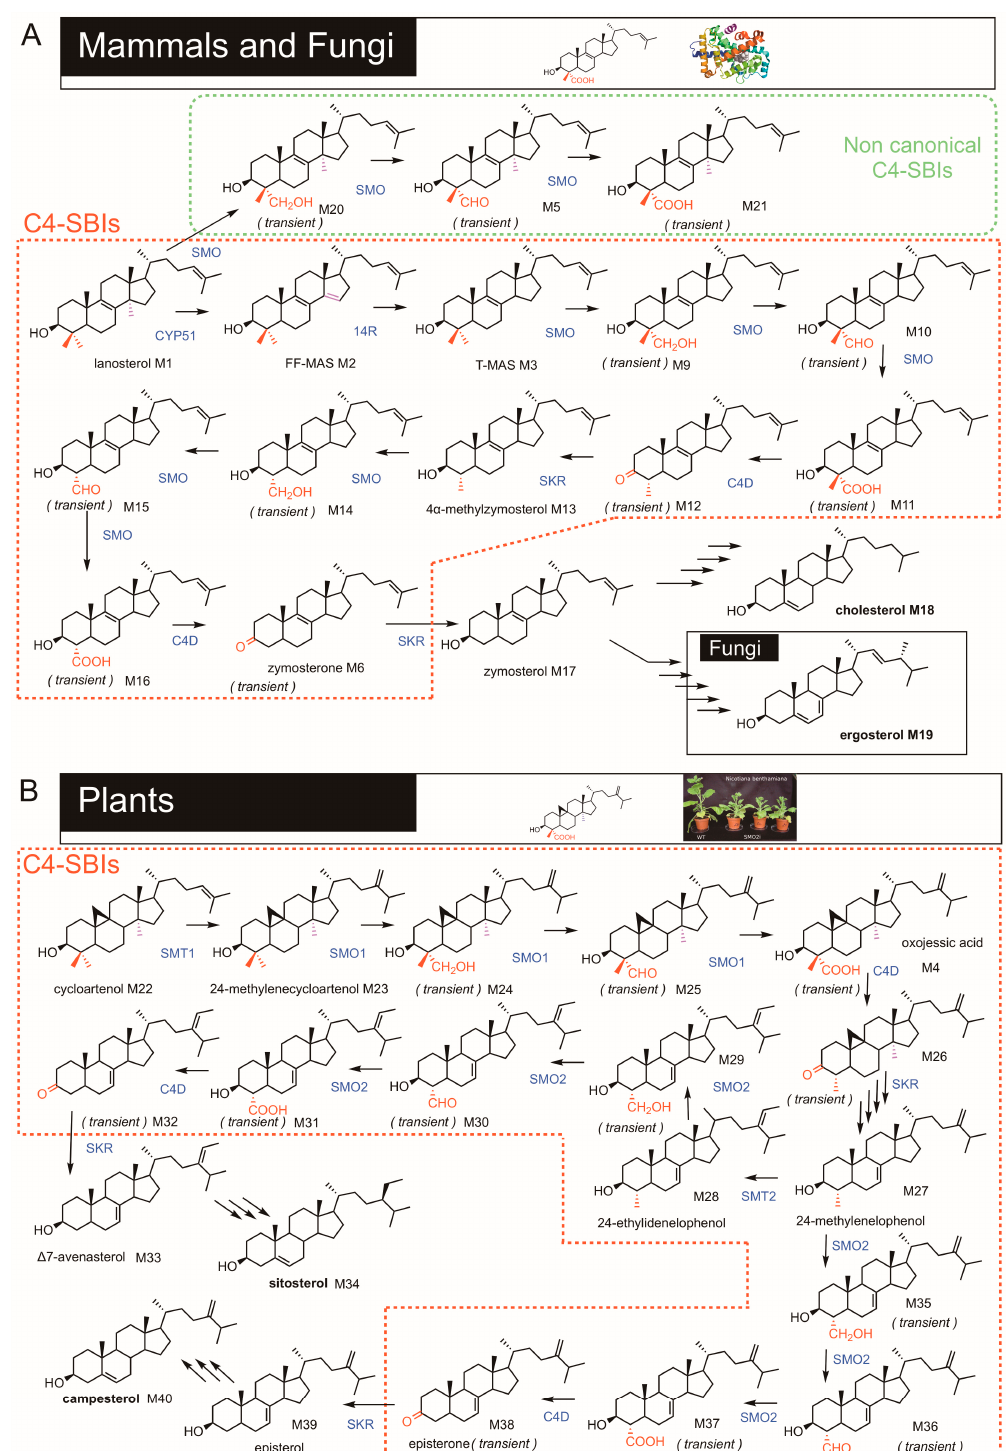
Figure 2. C4-demethylation pathways in mammals and fungi, and plants. Sterol nomenclature is given in Table 1. ( A ) pathways in mammals and fungi; ( B ) pathway in plants; C4-demethylation in eukaryotes: SMO, sterol-4 α -methyl-oxidase; C4D, 3 β -hydroxysteroid dehydrogenases/C-4 decarboxylase; SKR, sterone ketoreductase, C14-demethylation: CYP51, lanosterol-C14 demethylase. SMT, sterol methyltransferase; 14R, sterol-14-reductase. Each arrow represents an enzymatic step. Graphical insets are from references ([24] in top and [25] bottom